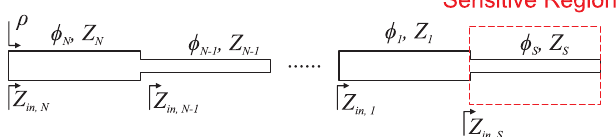
Figure 29. Schematic of the phase-variation sensor based on a sensing line and a step-impedance transmission line (with quarter-wavelength line sections). Reprinted with permission from Ref.